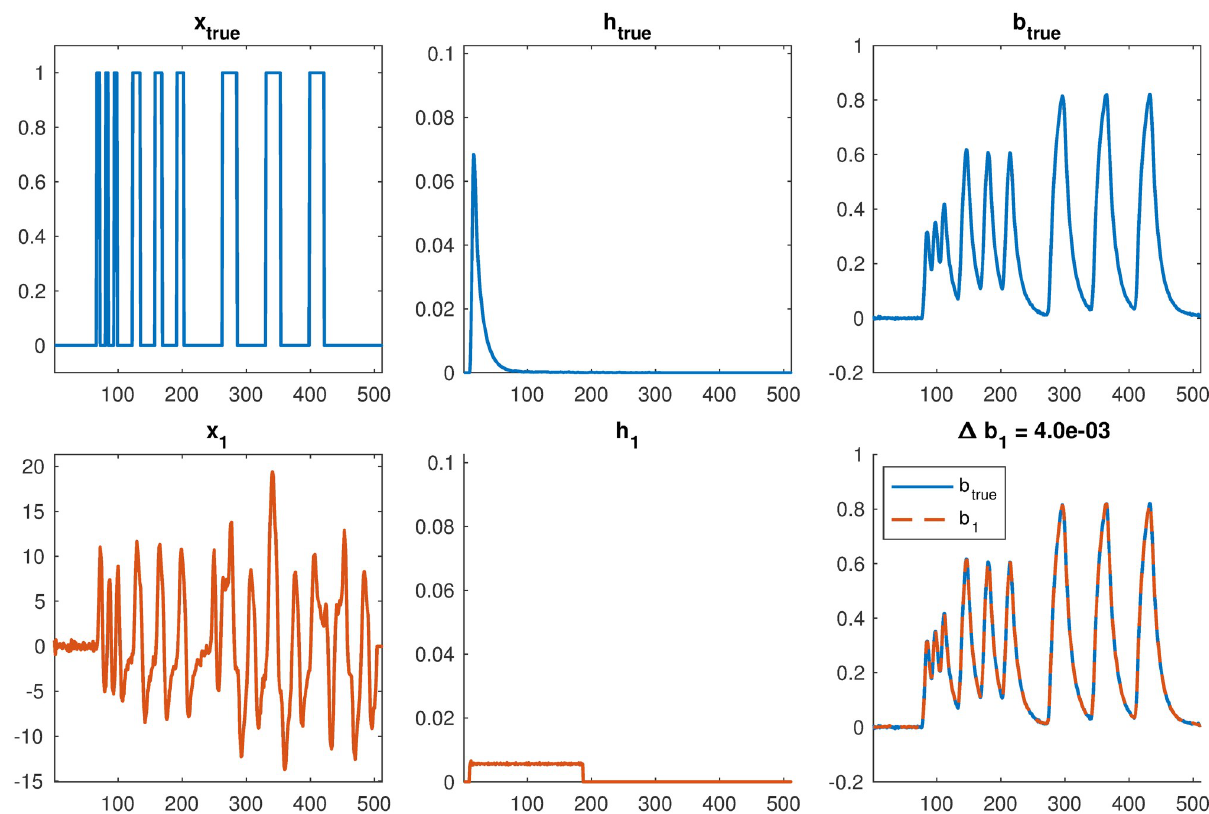
Fig 3. Illustration of the non-uniqueness problem in blind respirometry reconstruction. Both sets of parameters in x and h result in similar observed measurements in b . The result in the second row corresponds to using Tikhonov regularization for x and solving h using alternating